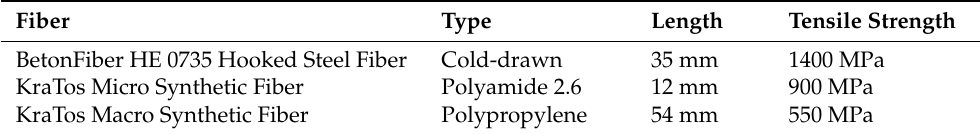
Figure 2. Fibers added into concrete mixtures. Table 3. Properties of fibers.